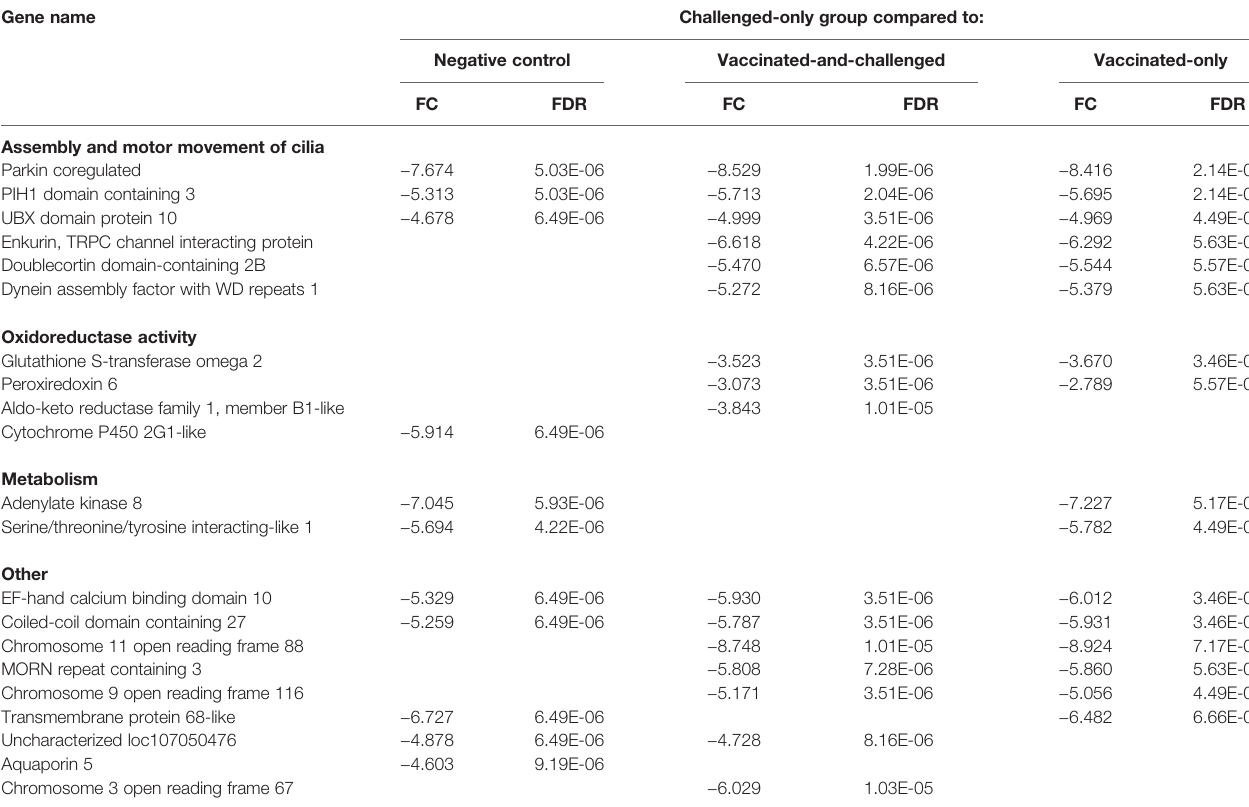
TABLE 2 | Log 2 fold changes (FC) and false discovery rates (FDR) of t he down-regulated genes among the 25 most differentially expressed genes based on FDR in the challenged-only group compared to the other